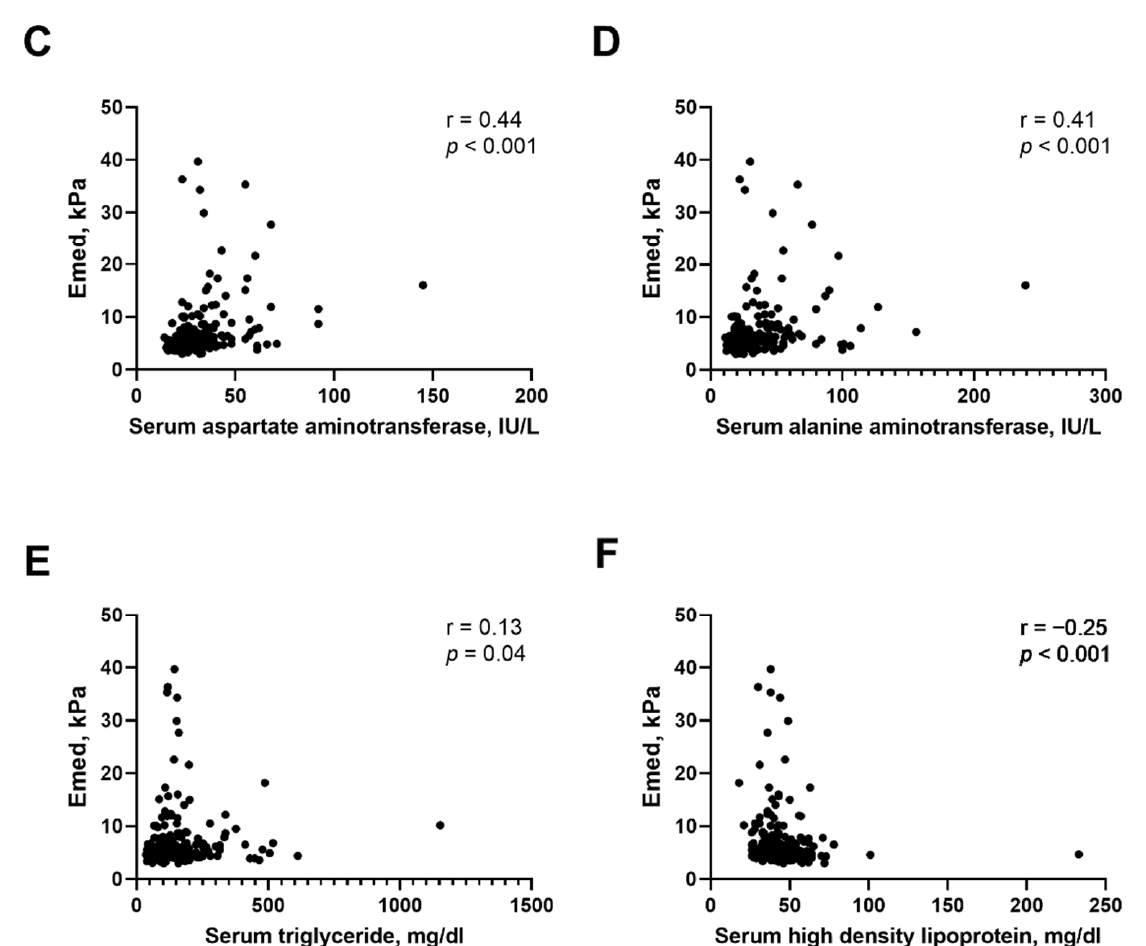
Figure 1. Correlation between Emed and clinical data in T2D patients with NAFLD. ( A ) body mass index. ( B ) serum uric acid level. ( C ) serum aspartate aminotransferase activity. ( D ) serum alanine aminotransferase activity. ( E ) serum triglyceride level. ( F ) serum high density lipoprotein level. Table 2. Logistic regression of determinants of liver fibrosis in T2D patients with NAFLD. Crude